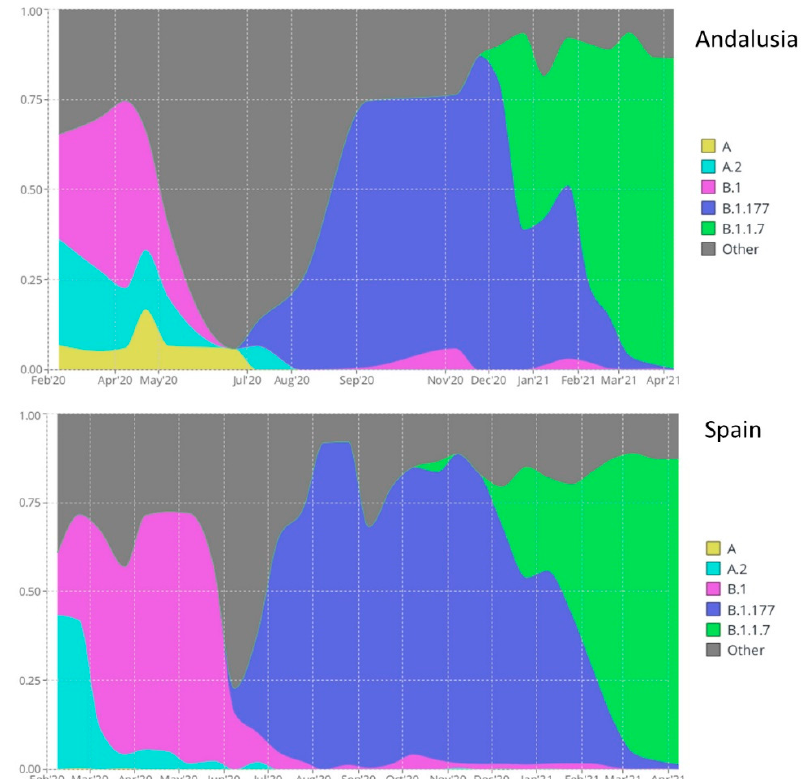
Figure 1. Circulation of the five SARS-CoV-2 variants eligible for the causal analysis in Andalusia ( upper panel ) and Spain ( lower panel ).